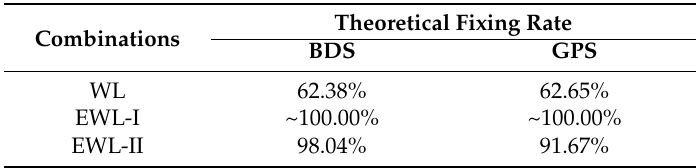
Table 3. Theoretical fixing rate of WL and EWL combinations.